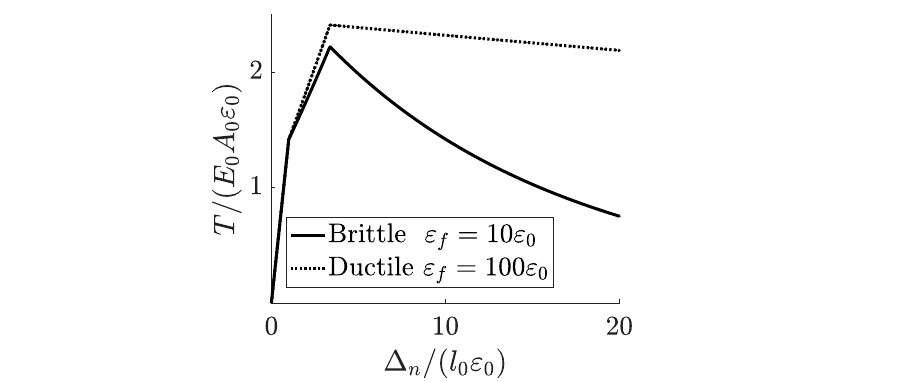
Figure 4. Normalized traction as a function of normalized opening for the two parameter sets considered, cf. Tab. 1.